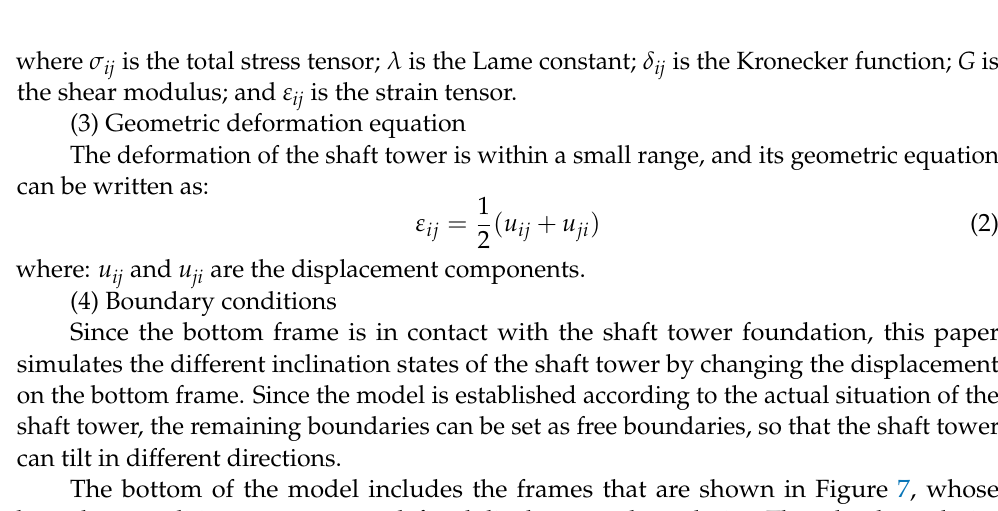
Table 2. Monitoring results of relative displacement at each monitoring point and predefined displacement equation on the bottom frames of the model.